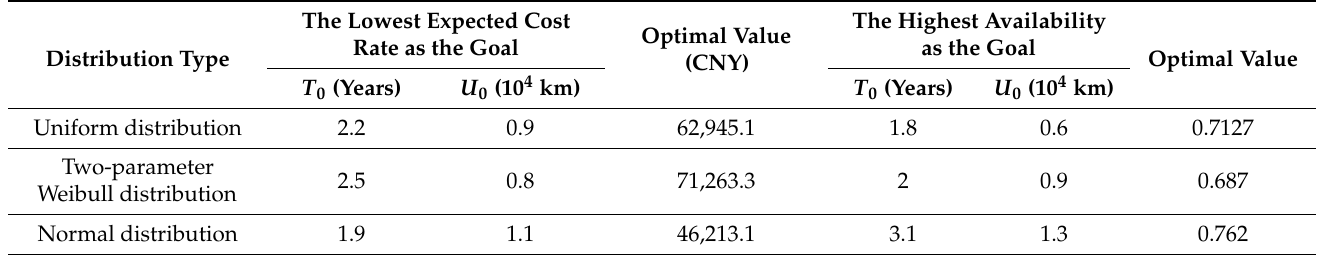
Table 6. The optimal scheme when the utilization rate follows different distributions.